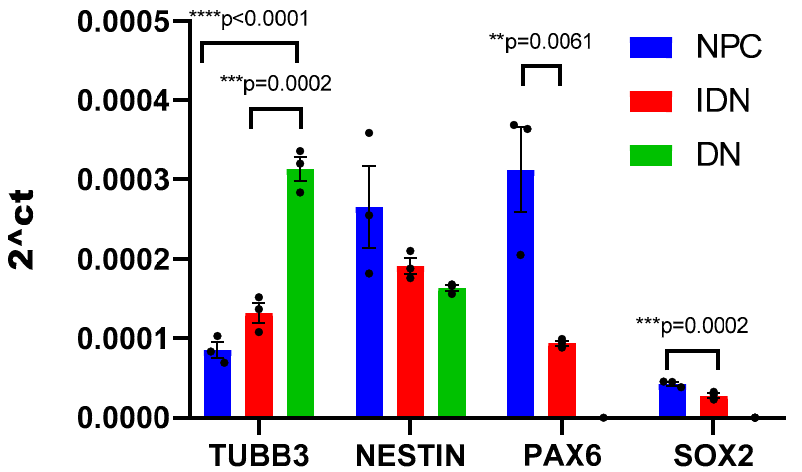
Figure 2. Neuron-specific gene transcription levels in the cell populations at different stages of differentiation. Individual repeat values in the histogram are indicated by black dots. Mean ± SEM, N = 3. One-way ANOVA followed by Dunnett’s post hoc test. ** p ≤ 0.01, *** p ≤ 0.001, **** p ≤ 0.0001.